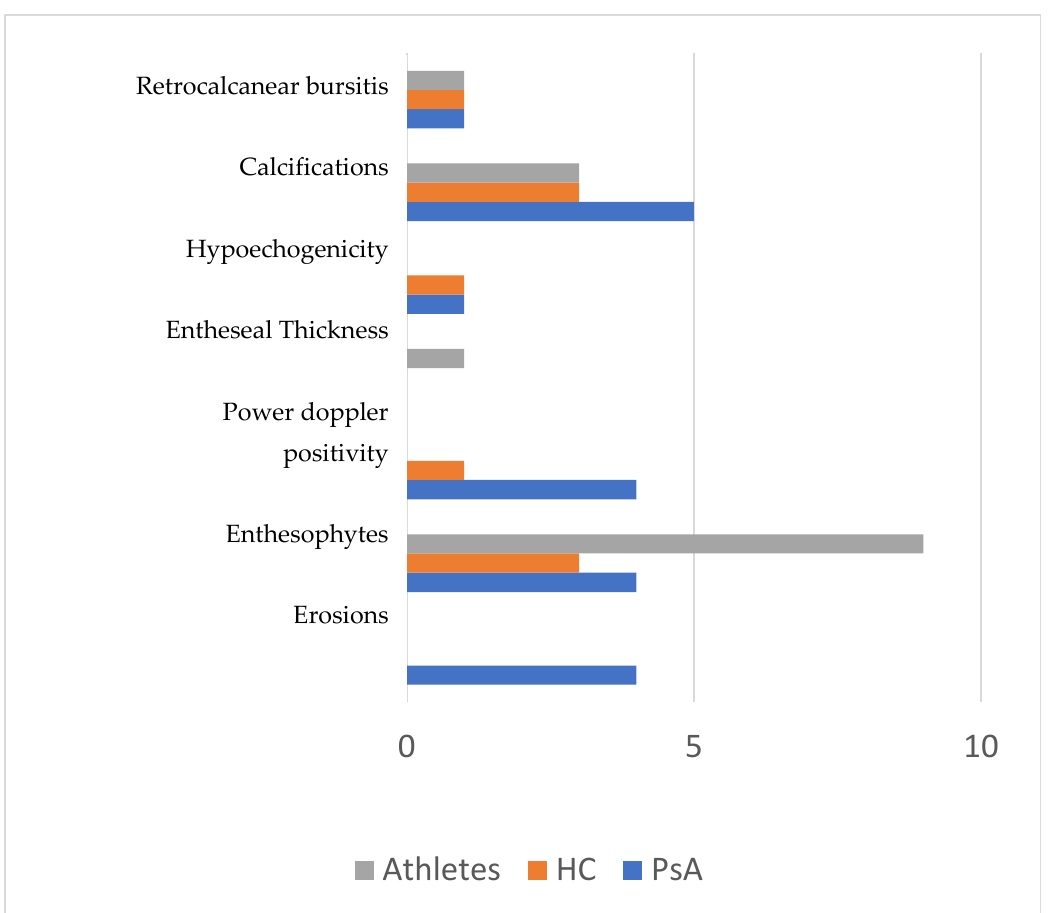
Figure 3. Ultrasound findings by group.